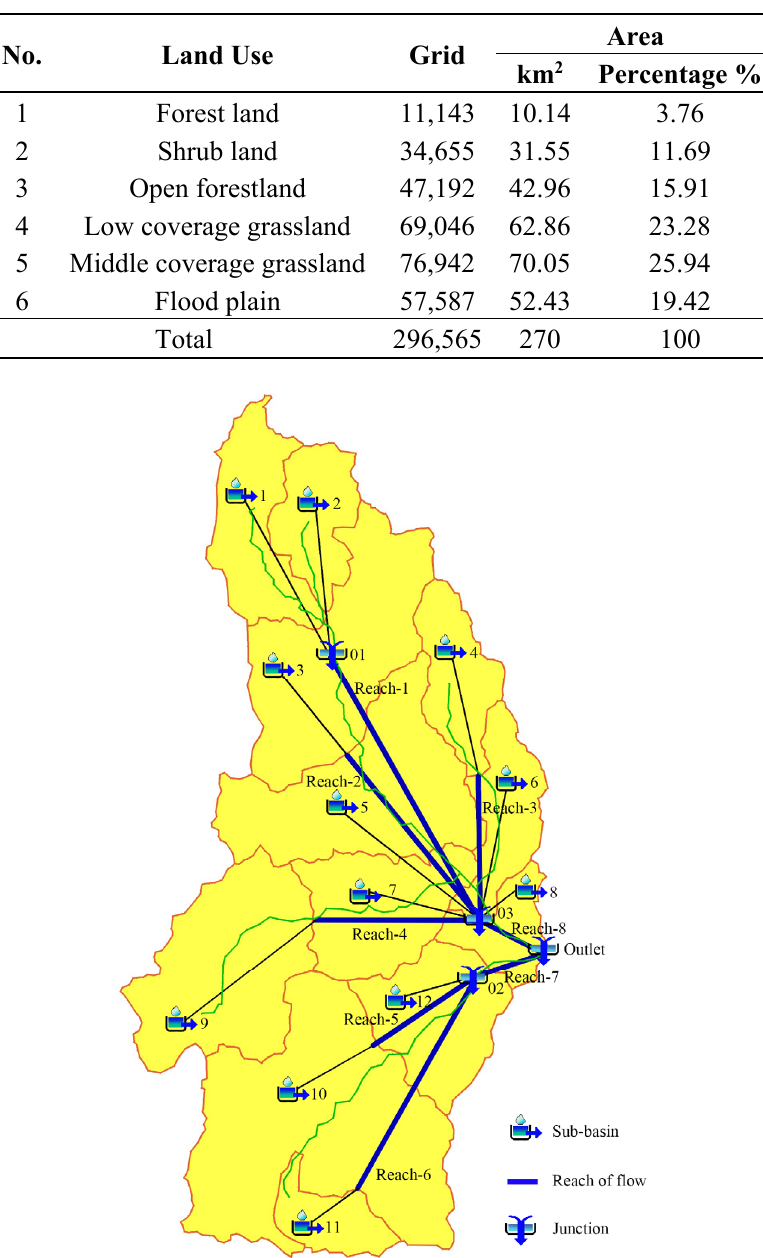
Table 2. Land Use Types of Jianghe Watershed.